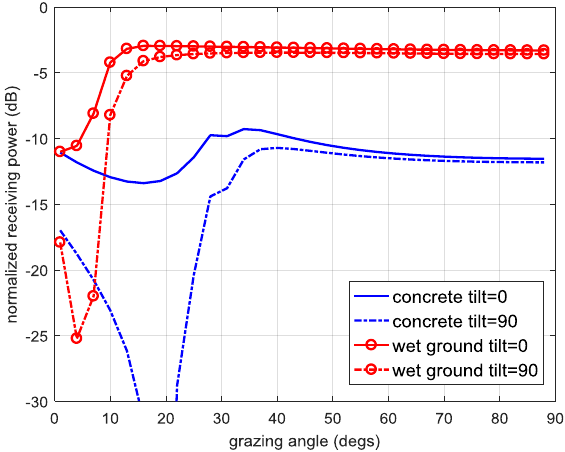
Figure 2. The relative power of the one-bounce multipath received by the LHCP antenna when different types of materials are used. The AR of the MP signal before reflection is 1.8 dB, and R L ( ψ 1 , ϕ 1 ) = 4 dB. The received MP signal power is normalized to that of the LOS signal. To sum up, the relative power of LOS and MP signals received by a dual-polarization antenna